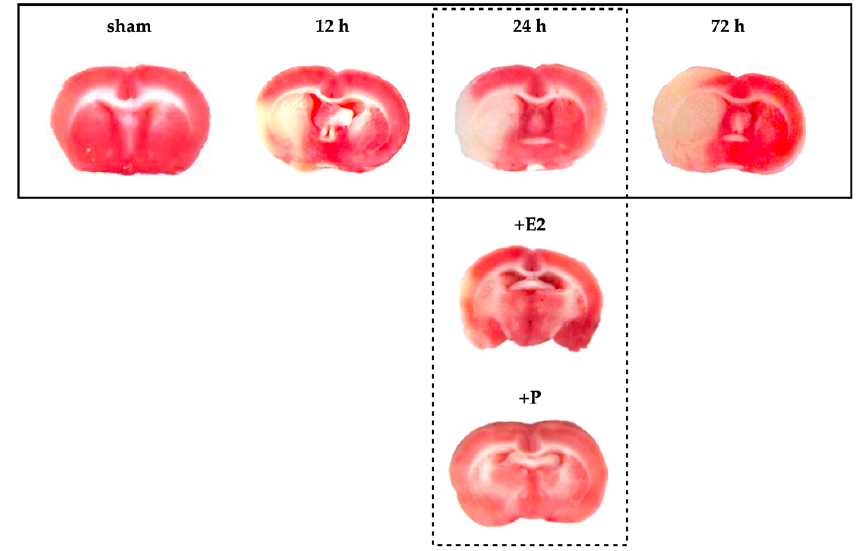
Figure A1. TTC-stained sections of brain slices. Brain slices were stained with TTC to discriminate living (deep red) from dead (unstained white areas) brain tissue. The infarct size increased with prolonged reperfusion time after tMCAO. E2 or P therapy significantly reduced the infarct size.